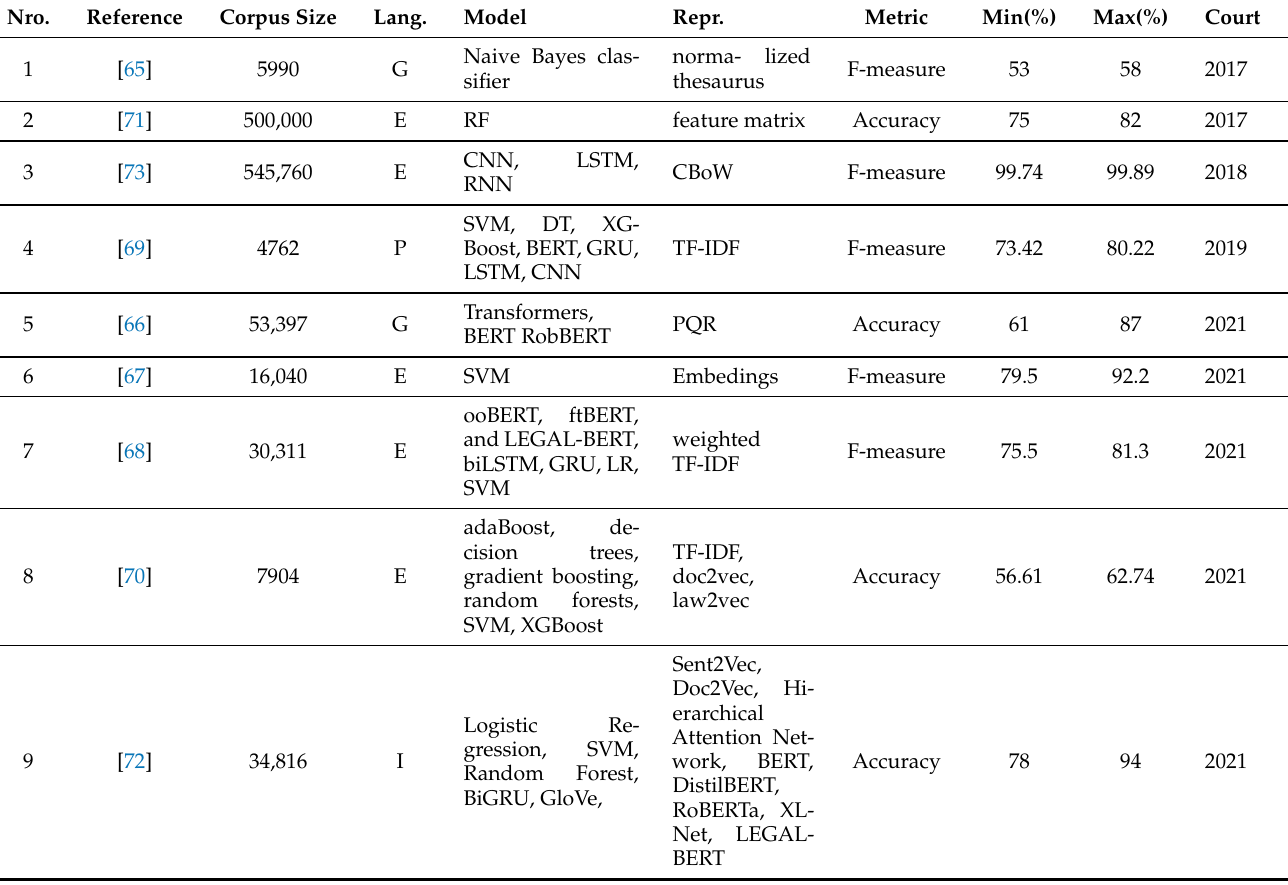
Table 4. Summary of ruling decision prediction in Tax Law, Intellectual Property, and Administrative Law, where E = English, F = French, G = German, P = Portuguese and I =